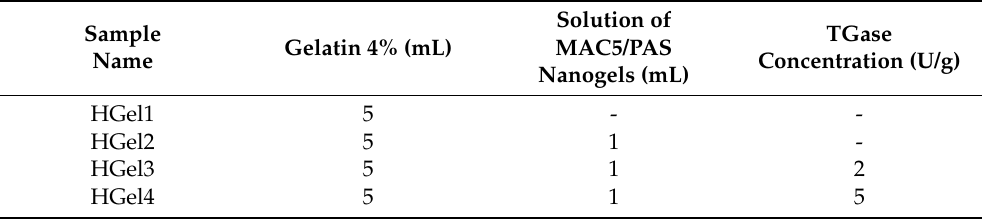
Table 1. Composition and codification of prepared